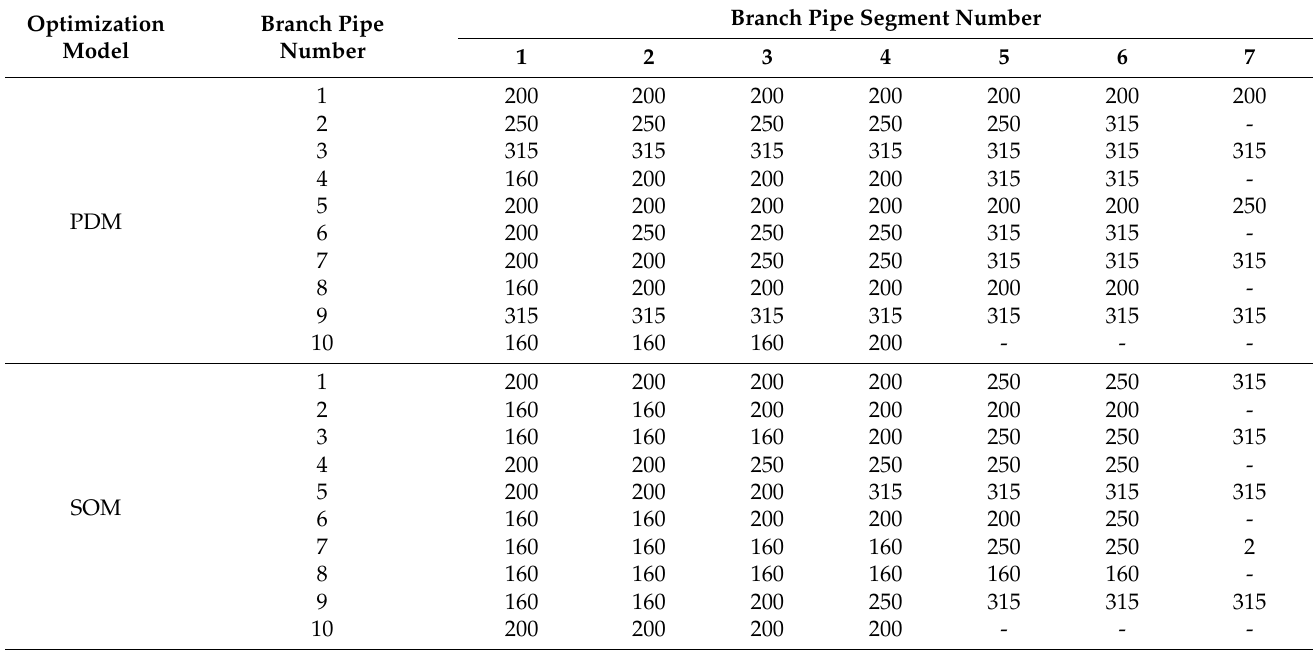
Table 6. The diameters of all branch pipe segments in the different irrigation